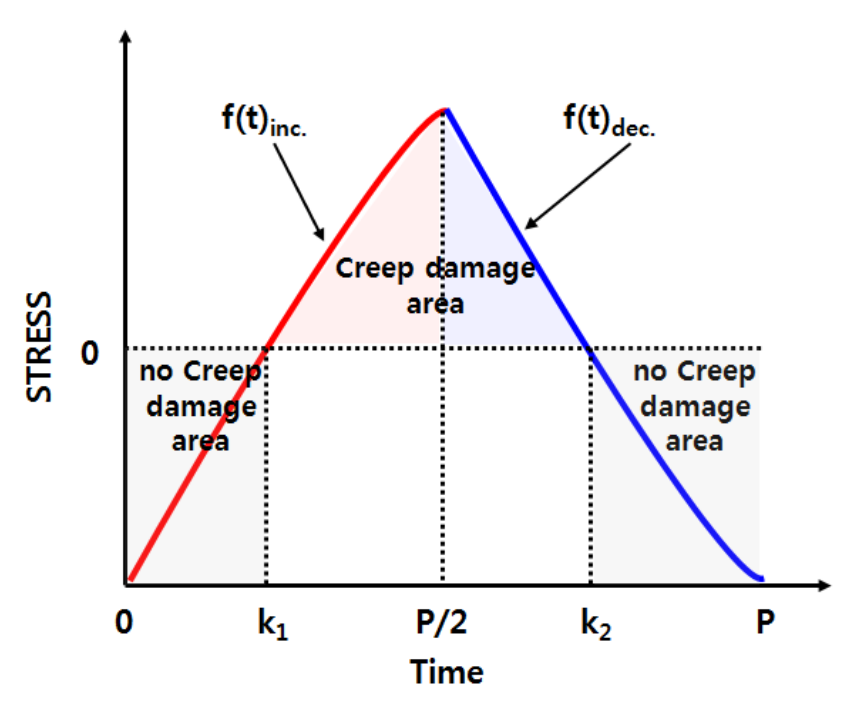
Figure 7. Creep damage area with respect to load conditions.